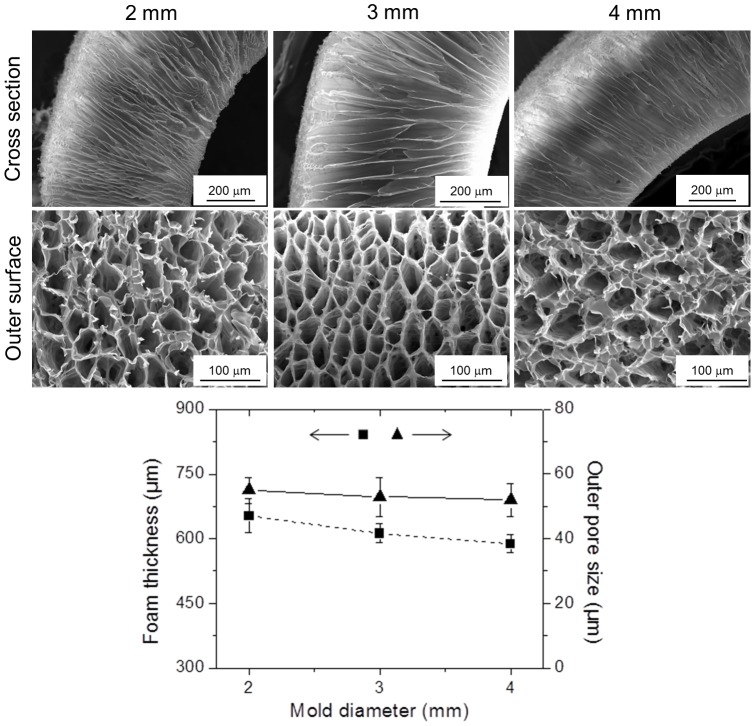
Influence of the mold diameter.SEM images of the cross section and the outer surface of the PLCL300 (5% w/v) foams prepared with molds of 2, 3 and 4 mm diameter at −80°C for 30 s demonstrated the ability to fabricate foams with variable inner lumen diameters without any significant change in the average pore size but with a slight thickening of the pore wall and decrease in the overall foam thickness. Measurements were performed by Image J (n = 25). The differences between any two groups were statistically not significant. The correlation coefficients between the mold diameter and outer pore size and foam thickness were calculated to be −0.92 and −0.98, respectively.